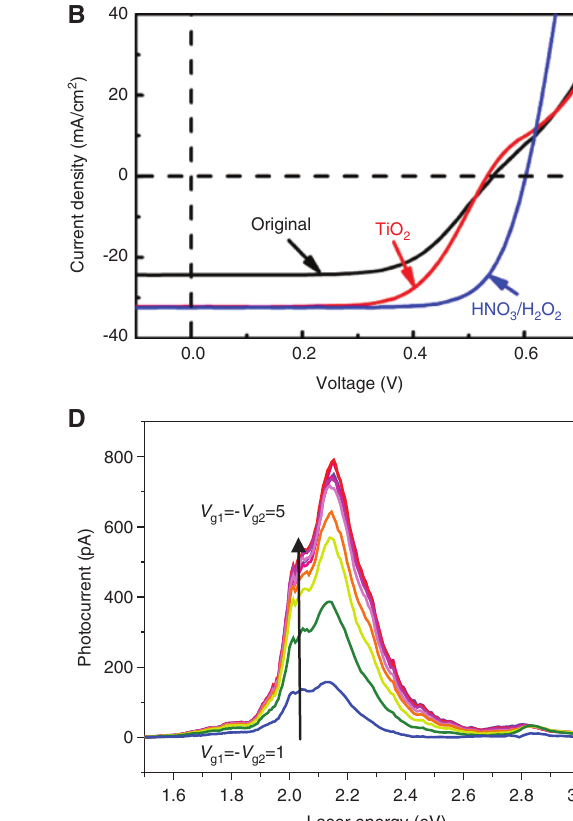
Figure 6: (A) Schematic diagram of the carbon nanotube/silicon junction with TiO J-V of the structure in (A) at different treatment processes. The highest efficiency obtained after HNO (C) Schematic diagram of carbon nanotube photodetector using a split gate structure. (D) Photocurrent enhancement with increasing gate = - V voltage ( V ) for the structure in (C) g1 g2